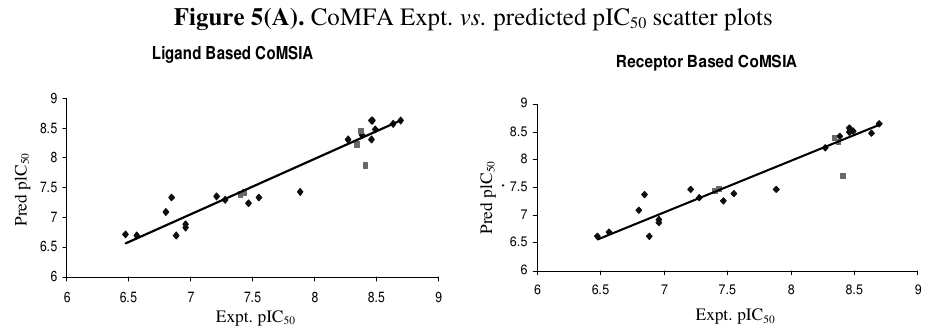
Figure 5(A). CoMFA Expt. vs. predicted pIC